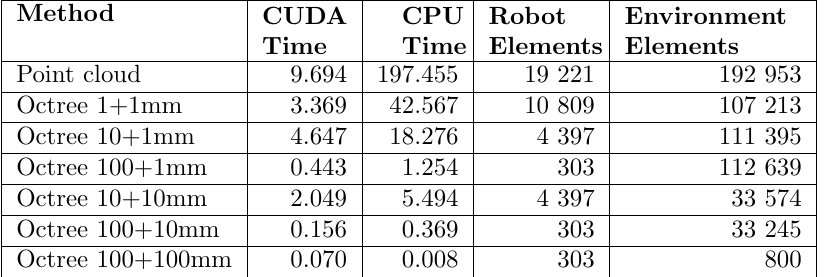
Table 1: Experimental results with a relatively small point cloud of environment. Octree X + Y mm means cubes with X mm sidelength for the robot and Y mm sidelength for the environment.